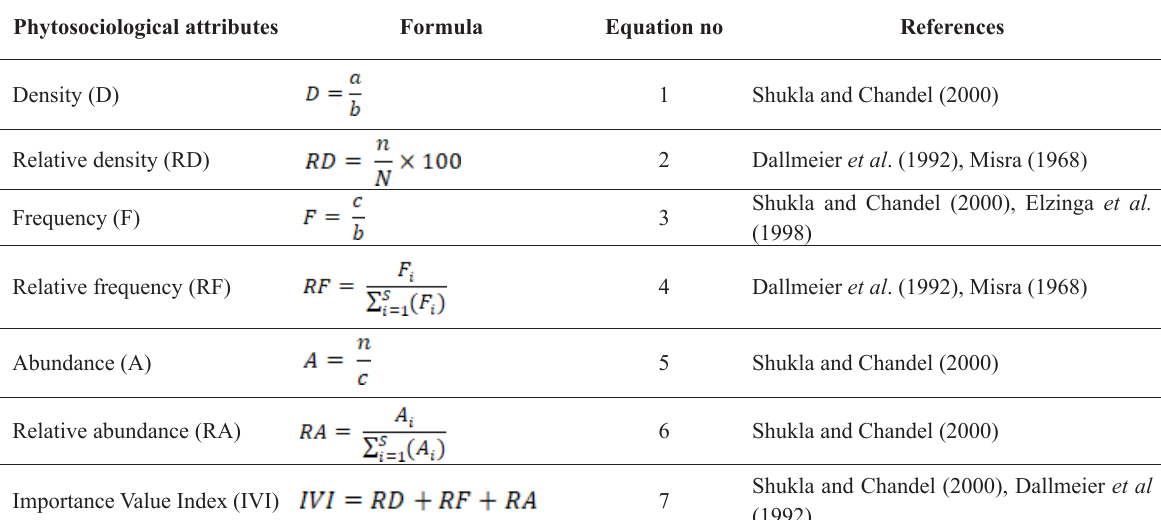
Table 1: The list of equations used for calculating phytosociological characters of the vegetation. Phytosociological